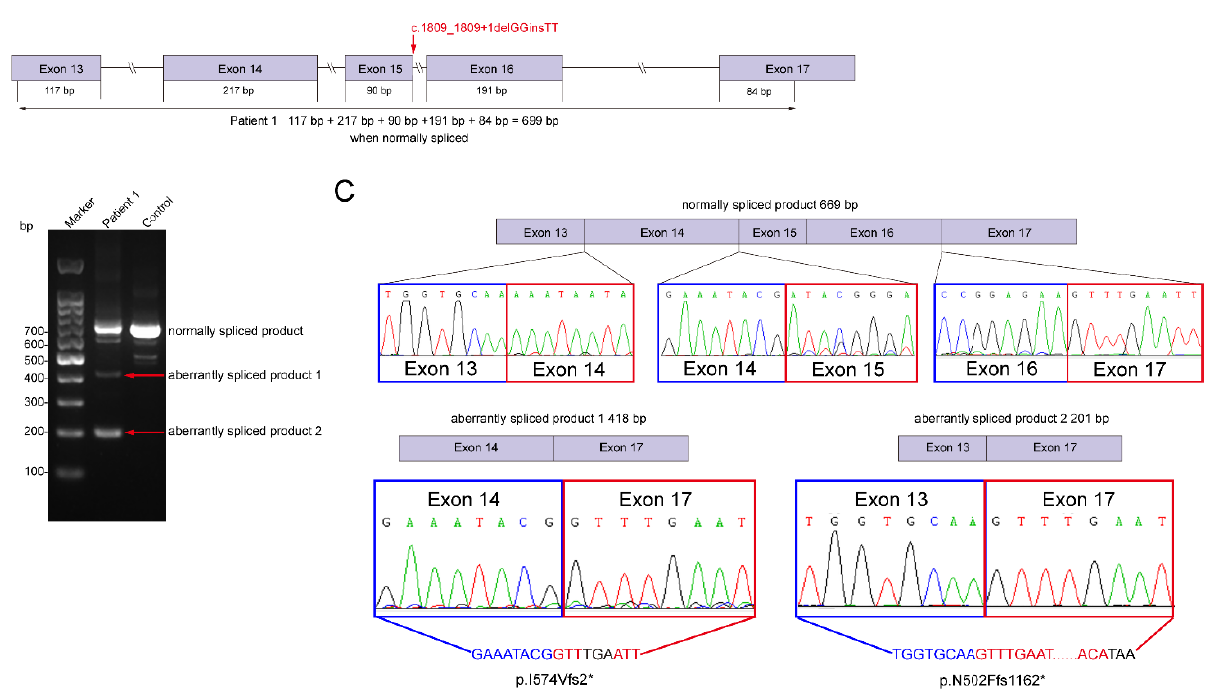
Figure 2. Molecular analysis of patient 1 ’ s CHD2 variants. ( A ) Schematics showing the location of primers and the variant c.1809_1809+1delGGinsTT within the CHD2 gene. ( B ) Agarose gel electrophoresis of amplified complementary DNA from patient 1 and the normal control, with the position of normally spliced (669 bp for line 3) and aberrantly spliced products (lines 2) indicated. ( C ) Sanger sequencing of the normally and aberrantly spliced products from Patient 1. The variant affects the normal splicing of mRNA, resulting in the skipping of exons 15 – 16 and 14 – 16.